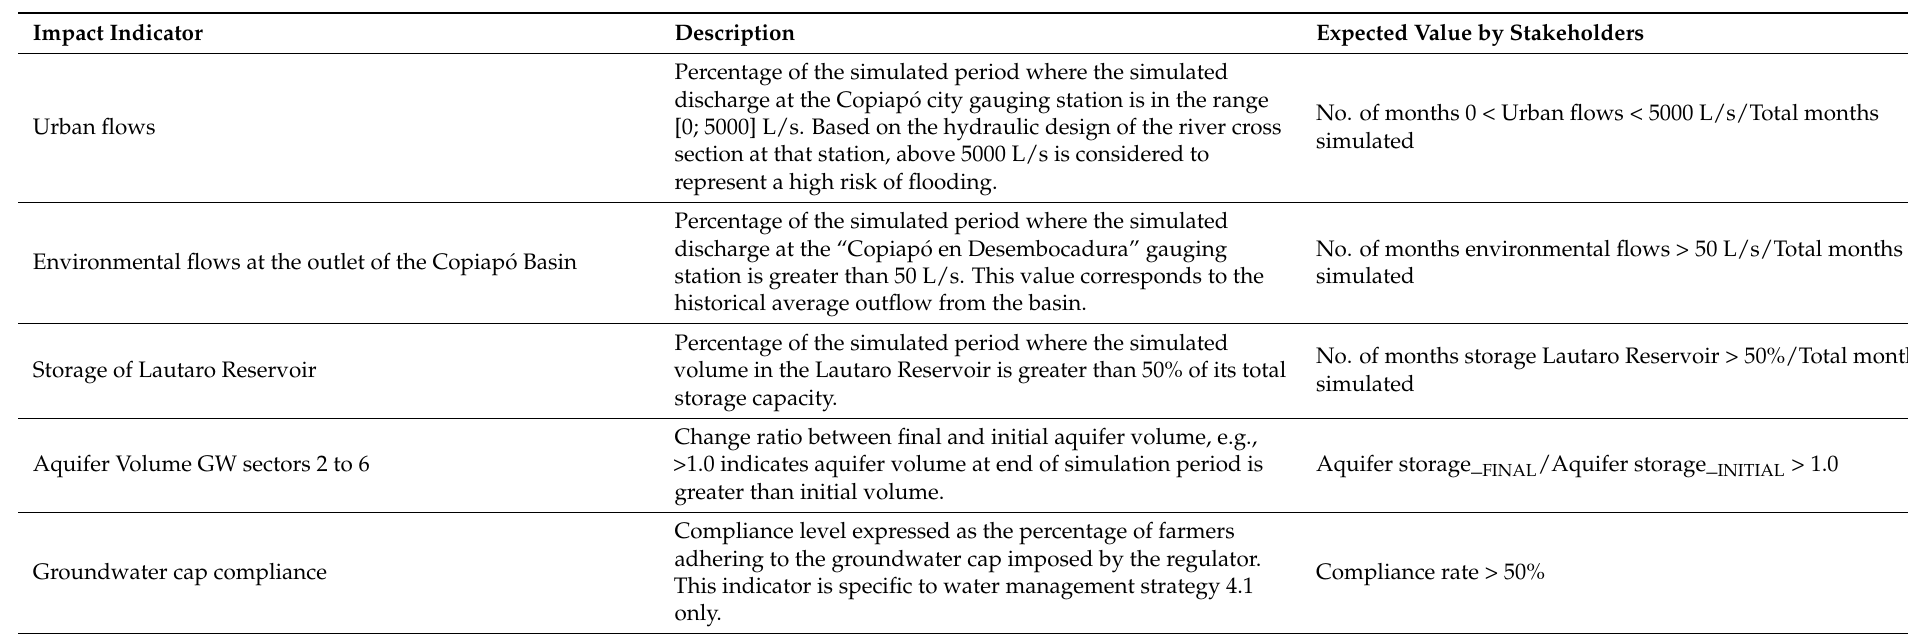
Table 2. Description of impact indicators and expected values co-designed with stakeholders through the participatory